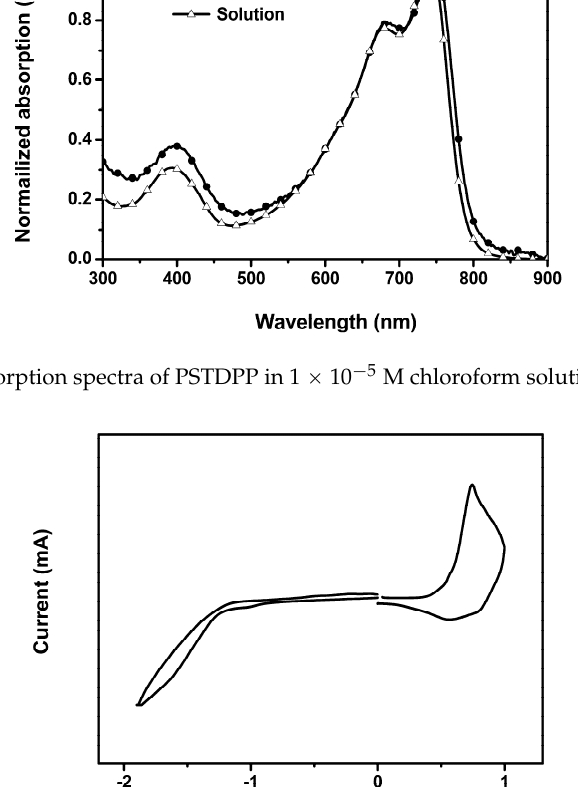
Figure 2. Cyclic voltammetry (CV) curves of PSTDPP at a scan speed of 50 mV s − 1 .